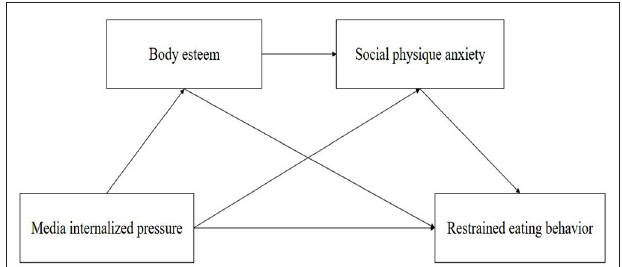
FIGURE 1 | Structural framework.